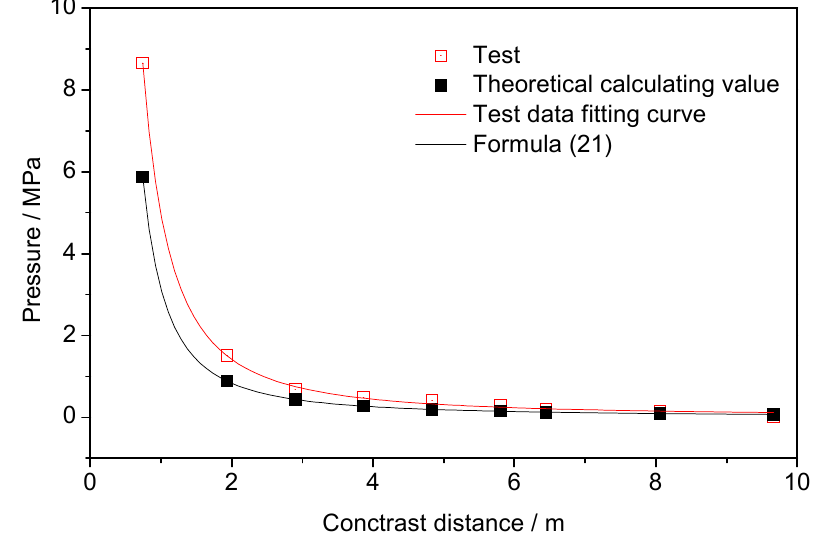
Figure 10. Comparison of liquid carbon dioxide blasting system and TNT pressure–contrast distance curve.